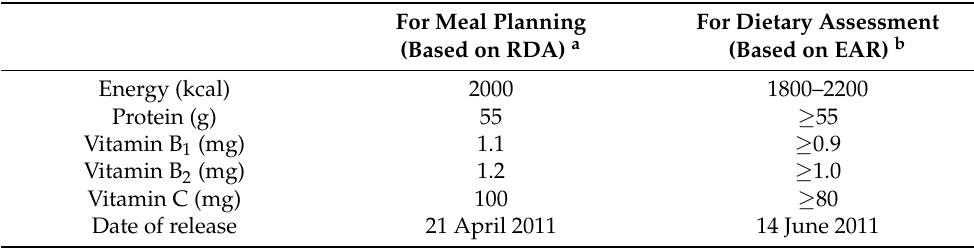
Table 1. Nutritional Reference Values at evacuation shelters (per day and per person aged 1 year and above).